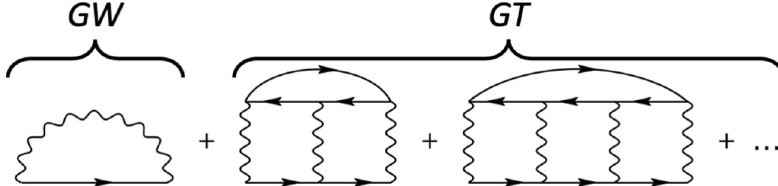
Fig. 9 GWT self-energy. Feynman diagrams representing the GW (electron – plasmon scattering) and the GT self-energy (electron – magnon scattering) are included in the combined GWT